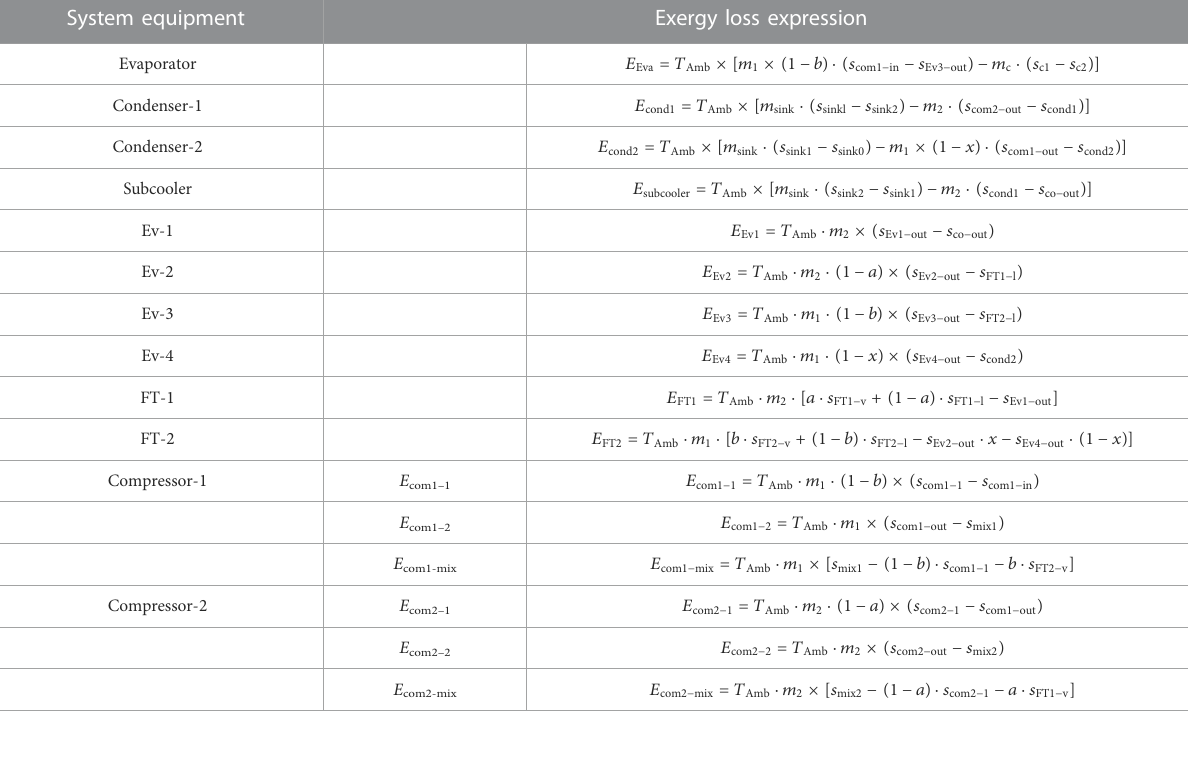
TABLE 1 Exergy loss model of each component. System